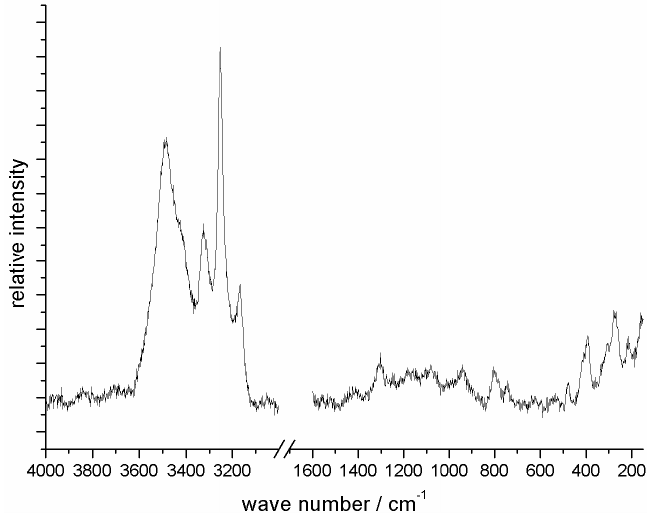
Figure 4. Raman spectrum of [Zn 2 (NH 3 ) 2 (NH 2 ) 3 ]Cl.